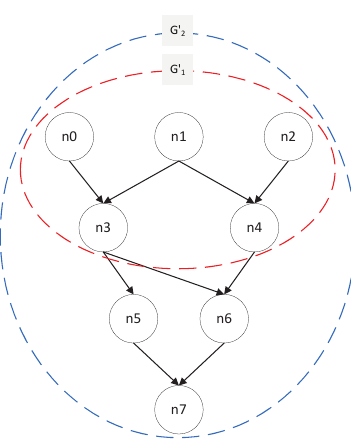
Figure 4. The graph partitioning result of the example